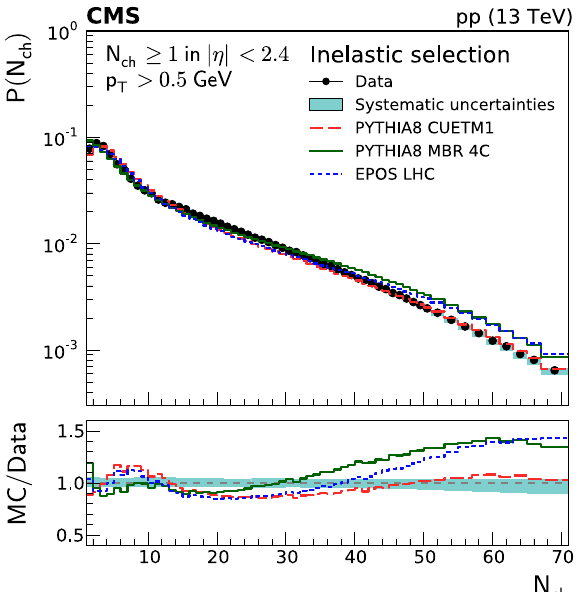
tors. The band encompassing the data points represent the total system- atic uncertainty, while the statistical uncertainty is included as a vertical bar for each data point. The lower panels show the corresponding MC- to-data